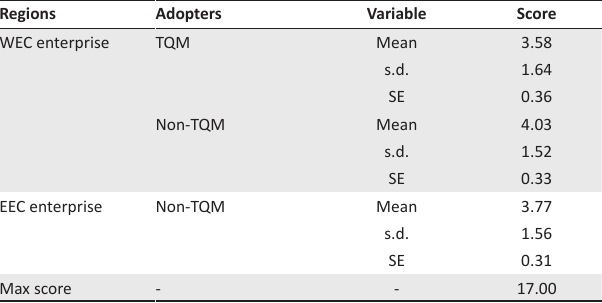
FIGURE 3 : Distinction of the regions’ enterprises according to their annual TABLE 2: Results of the regions’ strategic business planning performance scores.